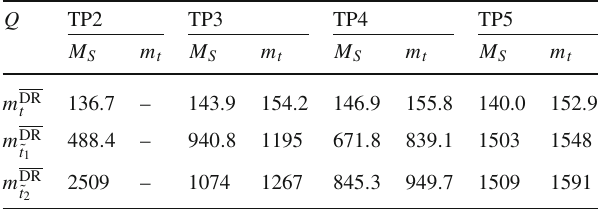
Table 11 DR top and stop masses, given in GeV, in the TP2–TP5 scenarios obtained by the routines of NMSSMCALC . The shift from